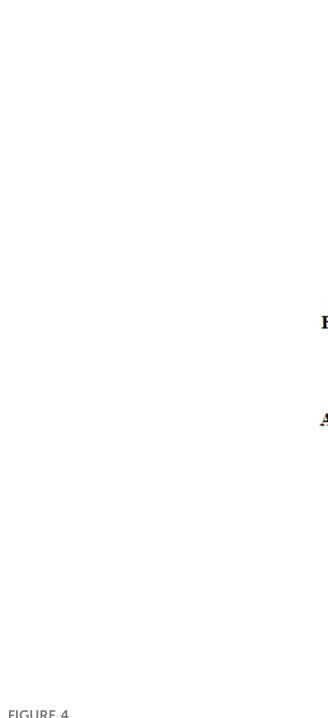
FIGURE 4 Heat map diagram of DEGs involved in quality-related